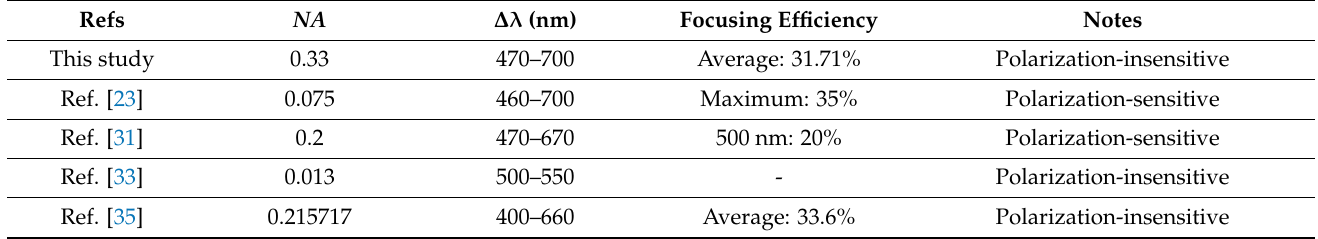
Table 3. Summary of features of achromatic metalenses in the visible light